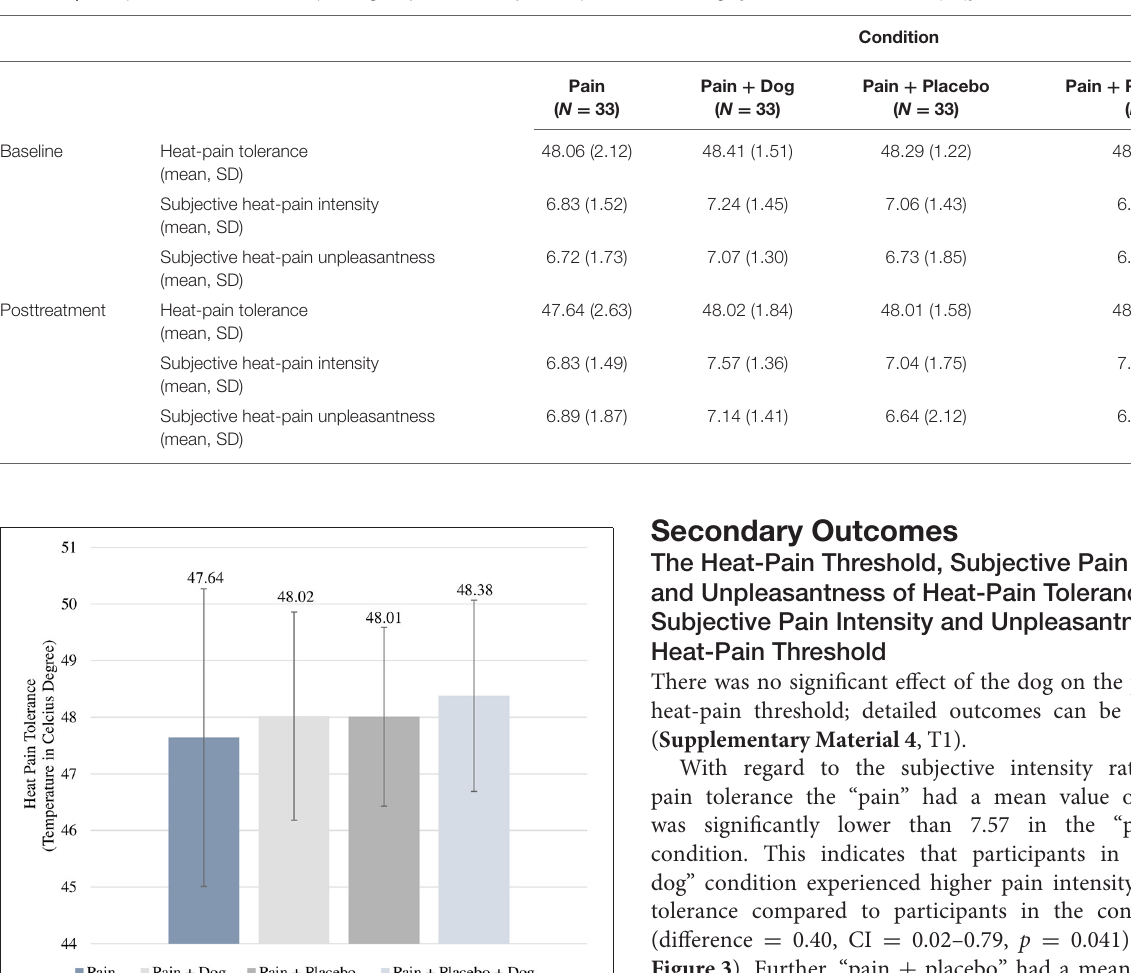
TABLE 2 | Heat-pain tolerance and corresponding subjective intensity and unpleasantness ratings [mean, standard deviation (SD)].